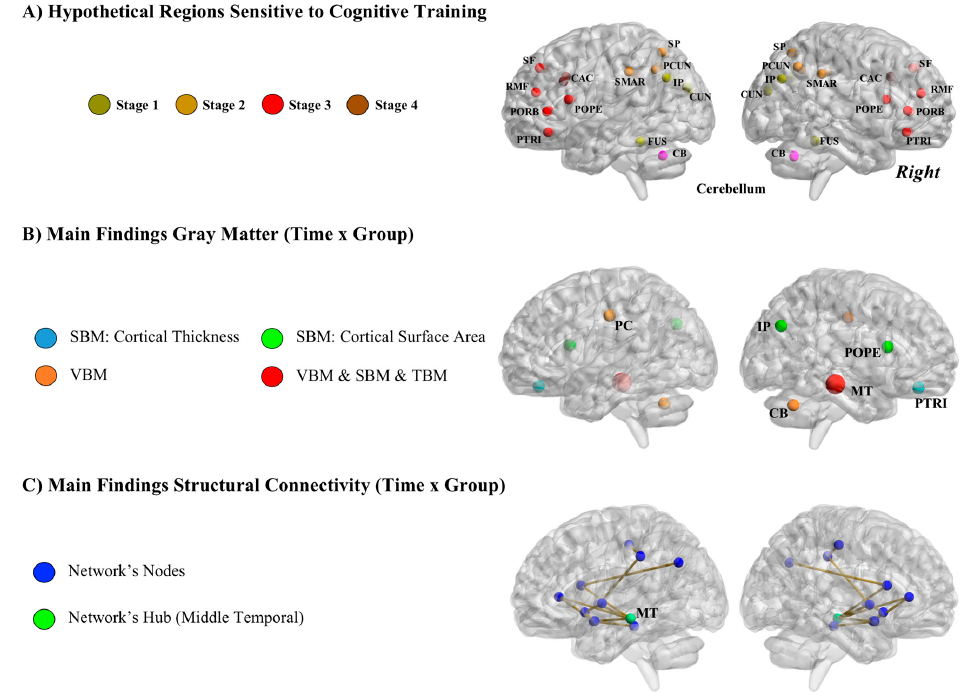
Figure 6. ( A ) Hypothetical regions sensitive to training defined after the parietal-frontal integration theory of intelligence (P-FIT). Stage 1, CUN = Cuneus, FUS = Fusiform Gyrus, IP = Inferior Parietal; Stage 2, PCUN = Precuneus, SP = Superior Parietal, SMAR = Supramarginal Gyrus; Stage 3 = POPE = Pars Opercularis, PORB = Pars Orbitalis, PTRI = Pars Triangularis, RMF = Rostral Middle Frontal, SF = Superior Frontal; Stage 4, CAC = Caudal Anterior Cingulate. ( B ) Summary of findings derived from longitudinal VBM (voxel-based morphometry), TBM (tensor-based morphometry), and SBM (surface-based morphometry) analyses. IP = Inferior Parietal, MT = Middle Temporal, POPE = Pars Opercularis, PTRI = Pars Triangularis, PC = Posterior Cingulate, CB = Cerebellum. ( C ) Summary of findings derived from structural connectivity analyses.